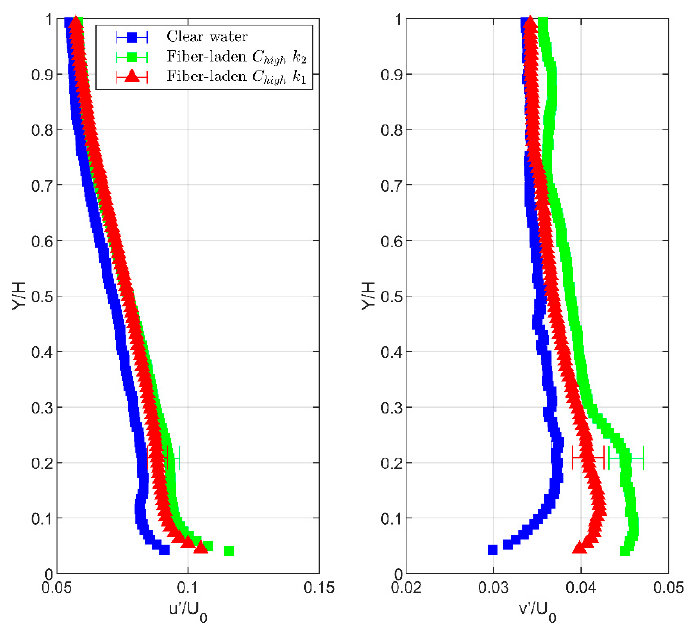
Figure 8. Carrier flow root mean square of stream-wise ( left ) and vertical ( right ) components of velocity. Clear-water case compared to the fiber-laden case at high concentration C high , two aspect ratios k 1 (red triangles) and k 2 (green squares). The 95% confidence error bars shown.